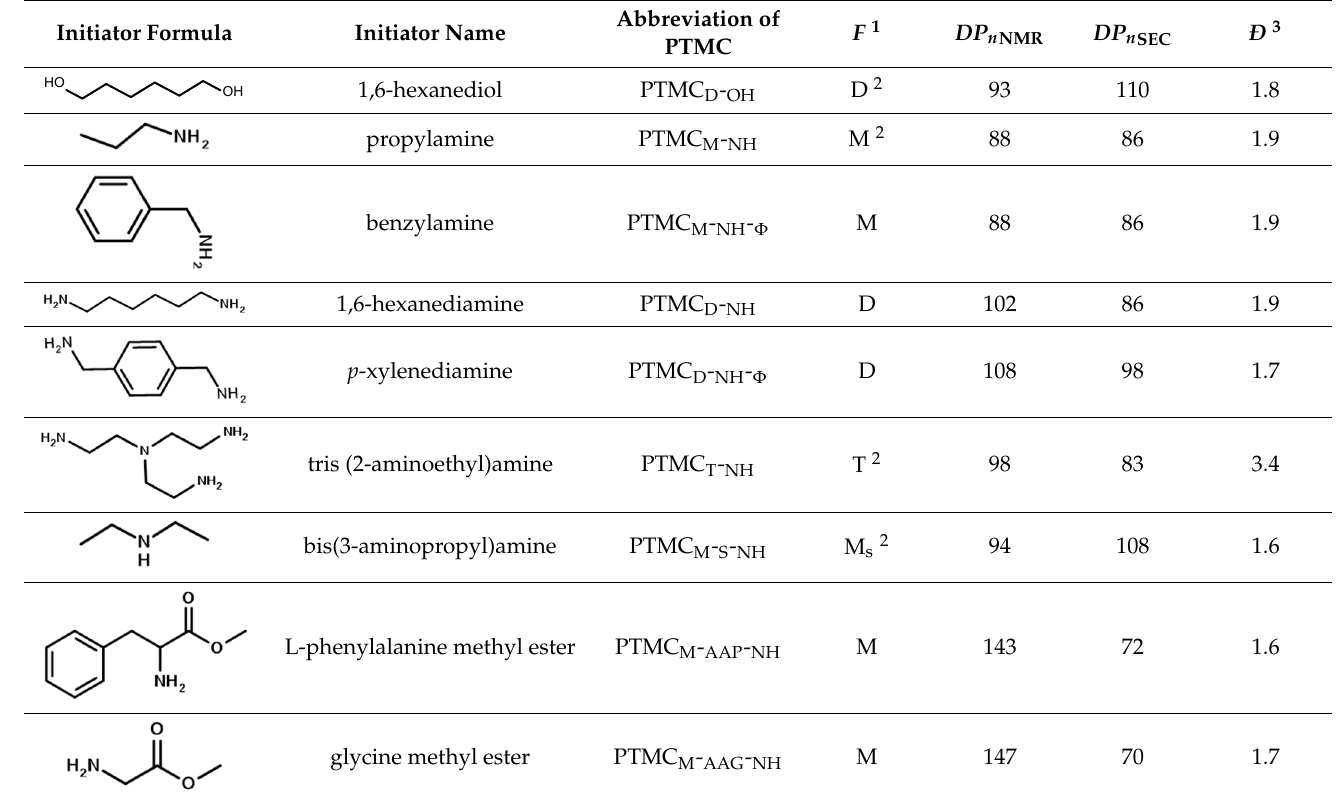
Figure 3. ( a ) 1 H NMR and ( b ) 2D-COSY NMR of PTMC initiated by 1,6-hexanediamine with Sn(Oct) 2 (CDCl 3 ).